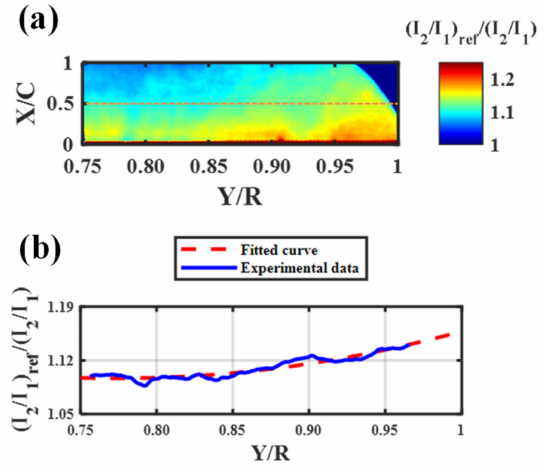
Figure 8. TSP field from TSP (840 rpm, θ = 4 ◦ ). ( a ) TSP I RoR field of TSP blade. ( b ) Span-wise temperature distribution extracted and effect of quadratic fitting at x/C = 0.5.